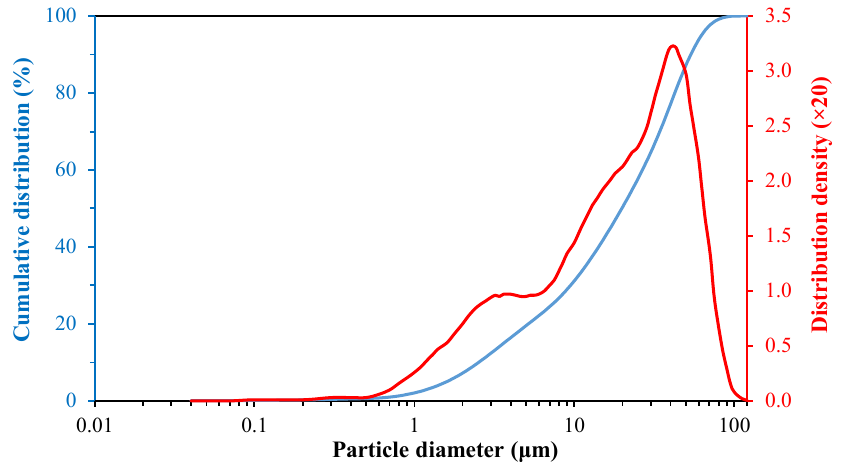
Figure 1. Particle size distribution of basalt.